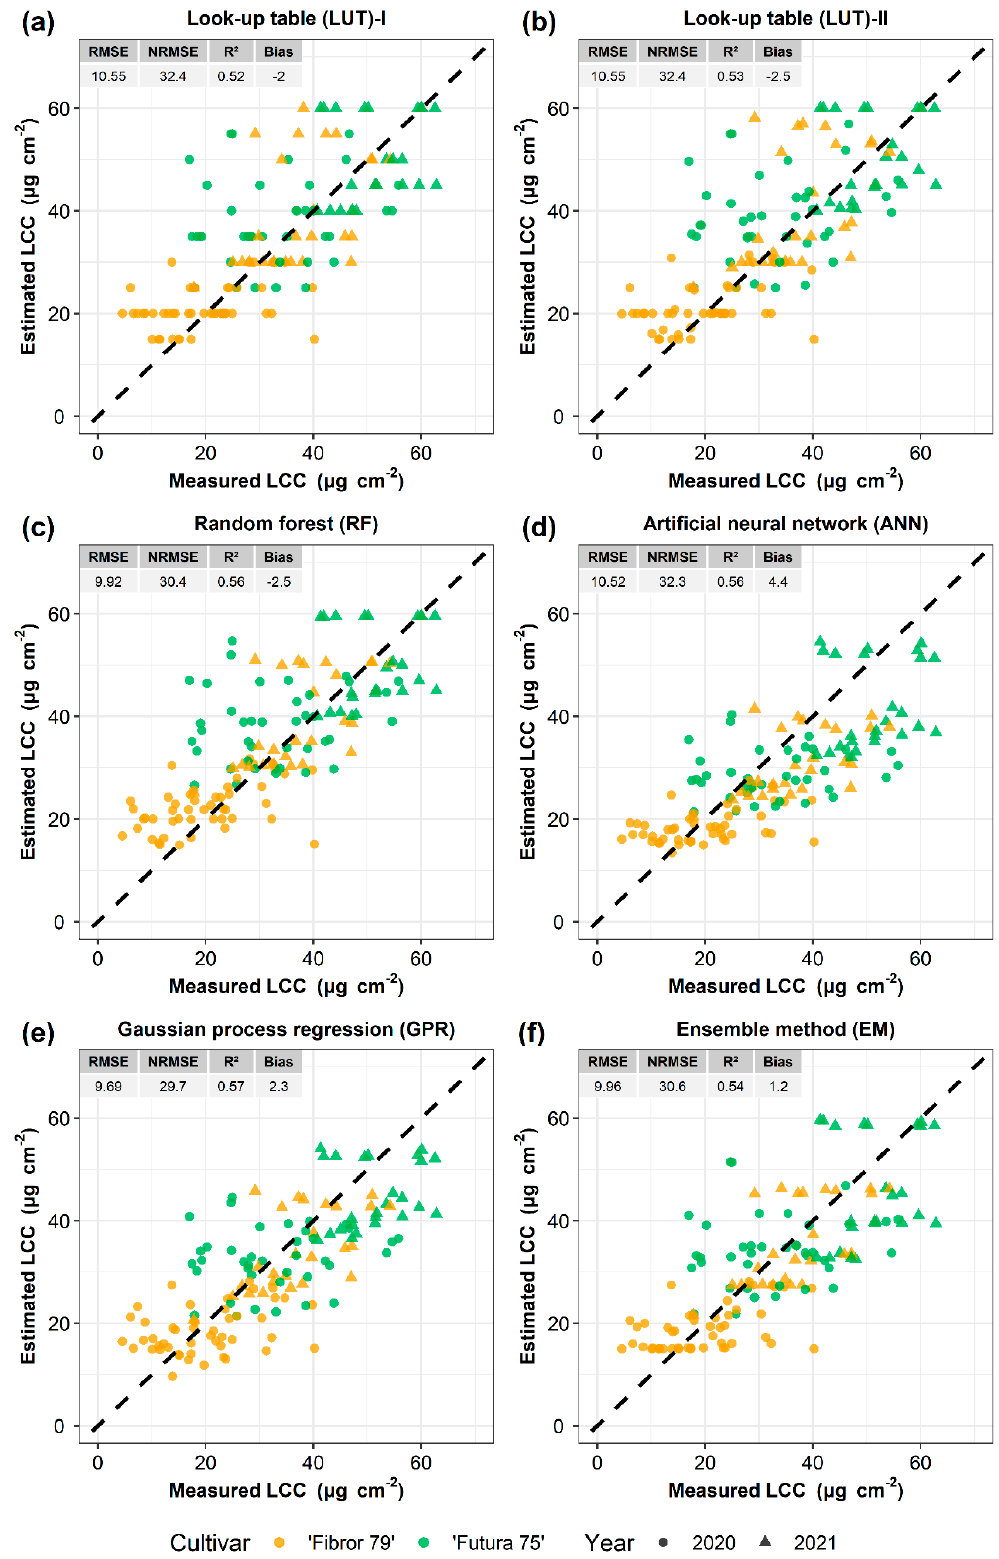
Figure 7. Estimated vs. measured LCC of hemp with different inversion methods: ( a ) LUT-I, ( b ) LUT- II, ( c ) RF, ( d ) ANN, ( e ) GPR, and ( f )